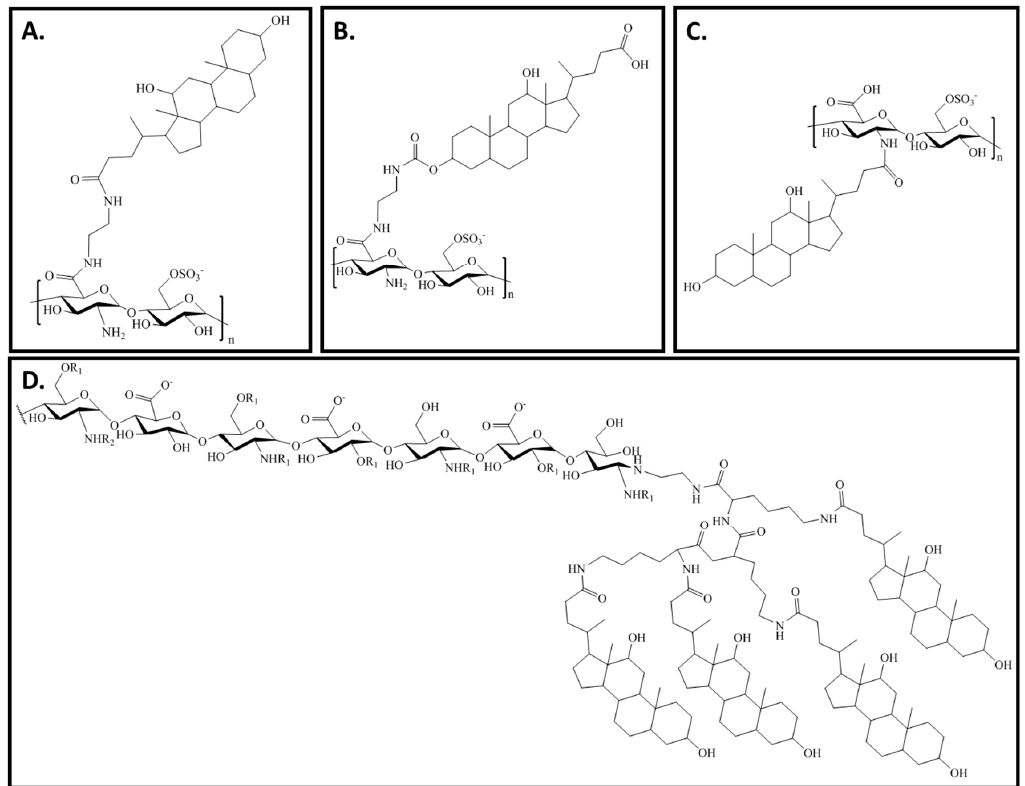
Figure 4. Structure of different heparins-DOCA conjugates. ( A) Heparin-DOCA conjugate in which both carboxylic groups of heparin and DOCA were conjugated through a linker [22–24,30,31,33]. ( B) Heparin-DOCA conjugate in which a carboxylic group of heparin and a hydroxyl group of DOCA were conjugated through a linker [29]. ( C) Heparin-DOCA conjugate in which an amine group of